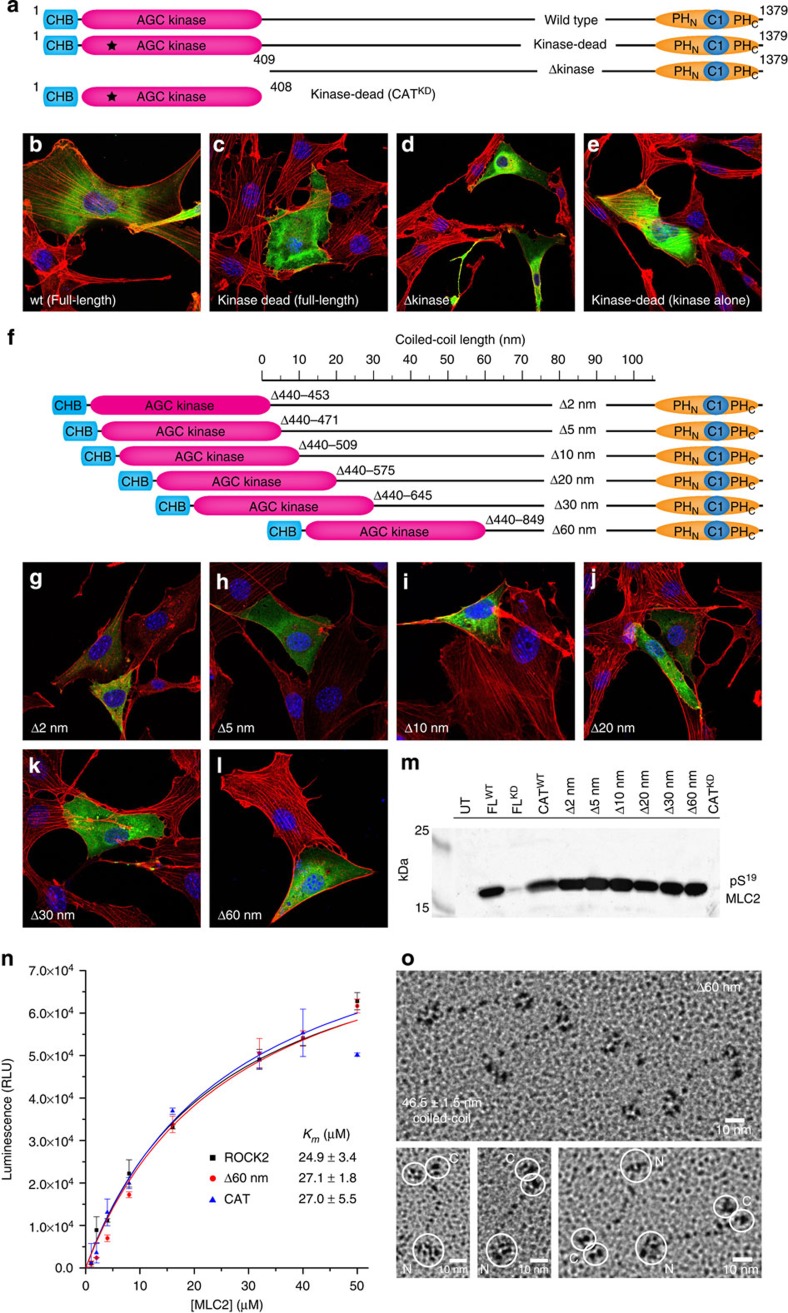
ROCK2 coiled-coil length regulates activity in vivo but not in vitro.(a) Schematic illustrating ROCK2 constructs used in b–e. (b) NIH3T3 ΔROCK2 cells expressing ROCK2WT have stress fibres indistinguishable from untransfected cells. (c) ROCK2K112A (kinase-dead)-expressing cells exhibit a dominant-negative phenotype characterized by the complete loss of stress fibres, while untransfected cells show normal stress fibres. (d) Cells expressing ROCK2409–1,379, a construct comprising the entire coiled-coil and the membrane-binding C1 and PH domains, also exhibit the complete loss of stress fibres. (e) Cells overexpressing ROCK21–409 K112A, a kinase-dead construct of the catalytic domain alone, exhibit normal stress fibres. (f) Schematic illustrating truncation constructs of ROCK2 used in g–l. (g) NIH3T3 ΔROCK2 fibroblasts expressing ROCK2 truncated by just 2 nm show normal stress fibres. (h) NIH3T3 ΔROCK2 fibroblasts expressing ROCK2 truncated in its coiled-coil by 5–60 nm (h–l) exhibit a complete loss of stress fibres. (m) In vitro kinase assay of ROCK2 mutants. Immunoblot of pS19 MLC2 following incubation with EGFP-tagged ROCK2 immobilized in a GFP-Trap 96-well plate. ROCK2WT is active against MLC2, while kinase-dead ROCK2K112A is completely inactive. ROCK2Δ2, ROCK2Δ5, ROCK2Δ10, ROCK2Δ20, ROCK2Δ30 and ROCK2Δ60 are all active against MLC2, as is the isolated kinase domain (CAT). (n) In vitro kinase assay of ROCK2wt, ROCK2Δ60 and ROCK2CAT. All three constructs show the same specific activity against MLC2. Error bars are the s.d. of three independent measurements. (o) Rotary shadowed electron microscopy of ROCK2Δ60. ROCK2Δ60 is an extended particle with a coiled-coil length of 46.5±1.5 nm (n=10). Asymmetry is illustrated by four particles with a single region of electron density at one end of the particle and two clear regions of electron density at the other.